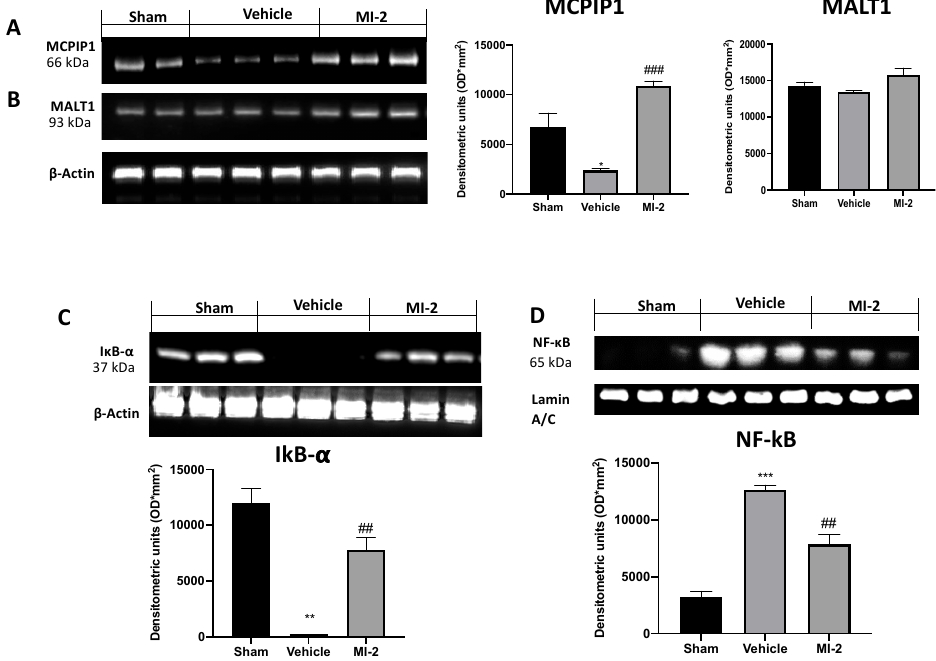
Figure 8. Effect of MI-2 on MCPIP1, Ikb- α , NF-kB expression: Western blot analysis of MCPIP ( A ), MALT1 ( B ), Ikb- α ( C ), and NF-kB ( D ). For each analysis, n = 10 animals from each group were employed.